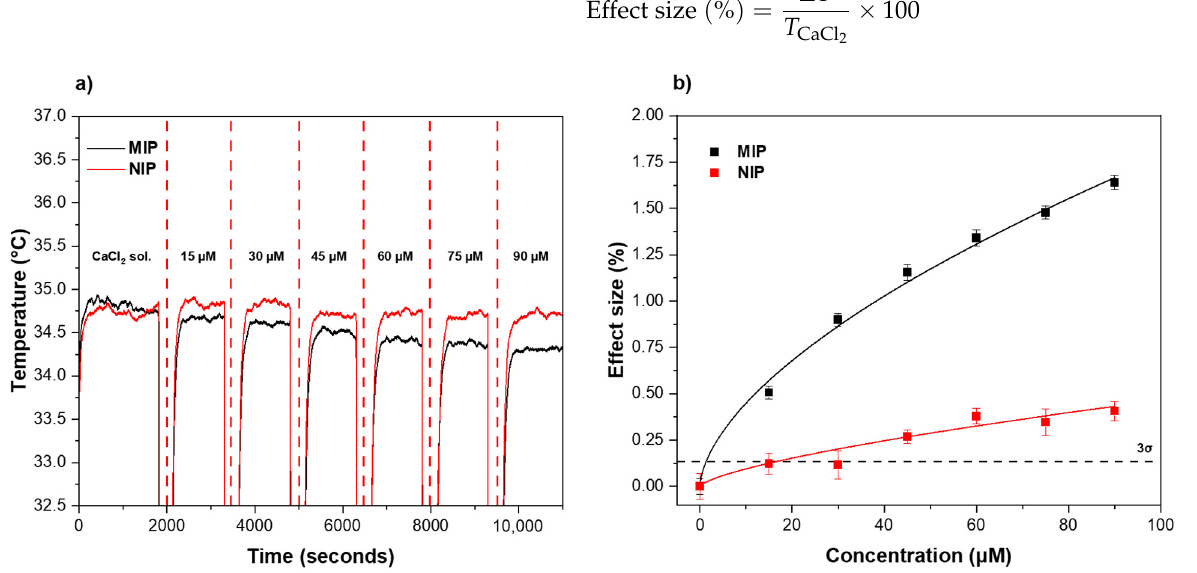
Figure 3. ( a ) Temperature profiles and ( b ) dose–response curves (from HTM analysis) of the MIP/NIP-based receptor layer after injections with increasing concentrations of melamine (0–90 μ M) in CaCl 2 . The LoD (3 σ method) of ±1.45 μ M is indicated by the black dashed line. Triplicate measurements were used to calculate the error bars and mean values.